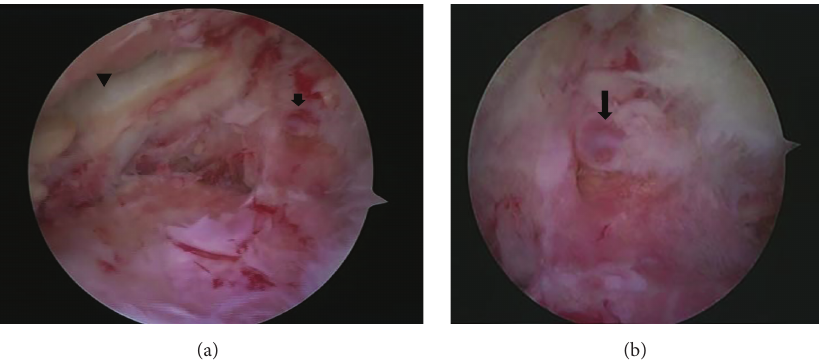
Figure 3: Arthroscopic findings of Case 1 . The lateral compartment has severe degenerative change and almost no meniscal substance, including the meniscal rim, is observed in the middle and posterior portions of the lateral meniscus. Arrow head indicates the remaining posterior horn of the lateral meniscus (a). On the synovium behind this area, a small projecting tubular soft tissue with pulsation (arrows) is shown (a and b).